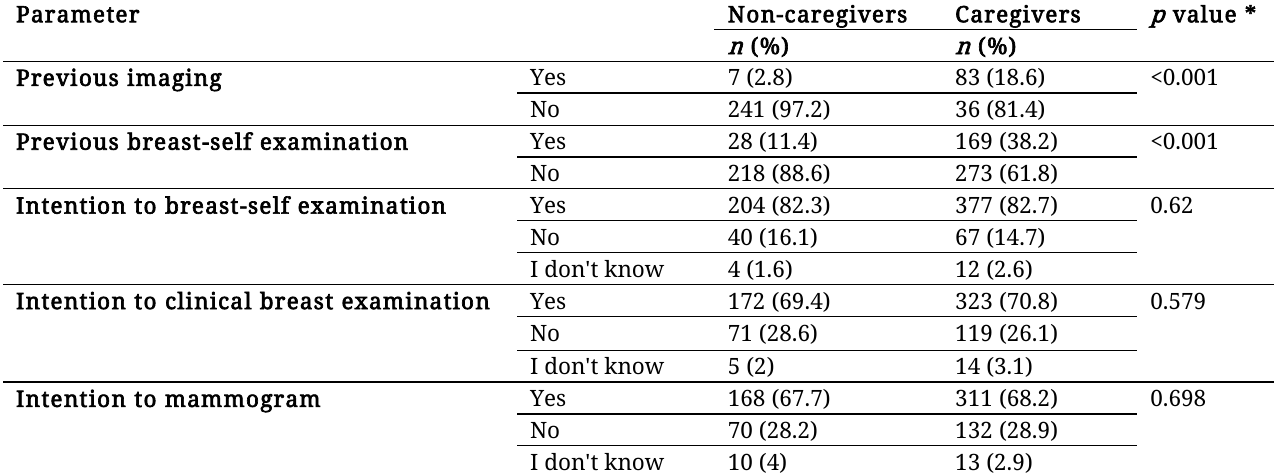
Table 6: Comparison of current behaviour and future intent to perform breast cancer screening between non-caregivers and